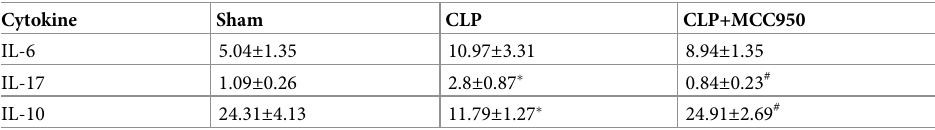
Table 1. Pro and anti-inflammatory cytokines.